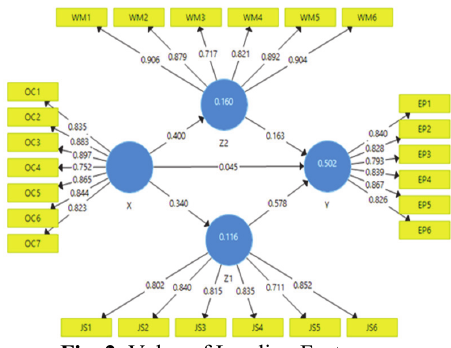
Fig. 2. Value of Loading